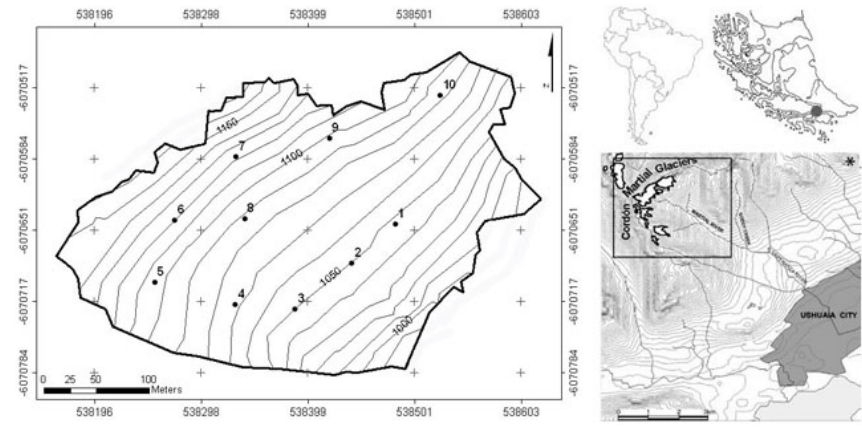
Fig. 1. Glacier location and distribution of ablation stakes over Martial Este Glacier (April 2005). ∗ Strelin and Iturraspe (2007).